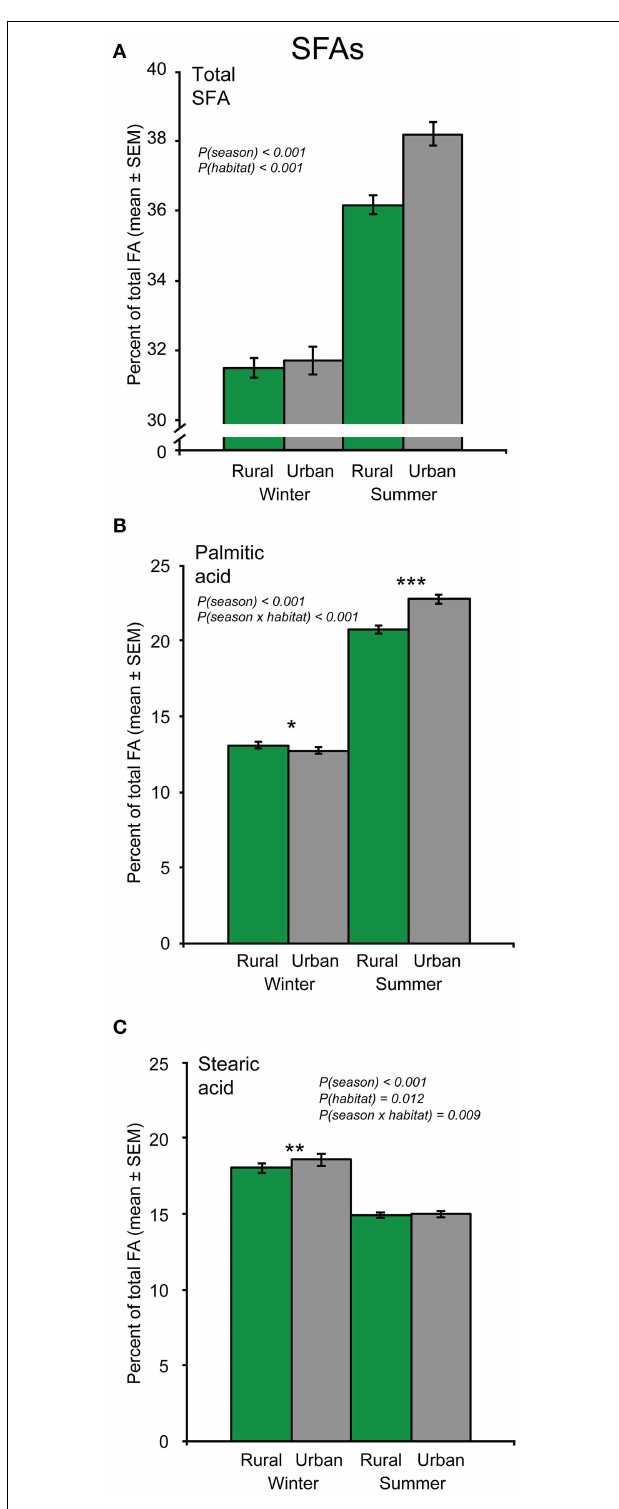
FIGURE 6 | The proportion of saturated fatty acids (SFA) in great tit blood plasma sampled during winter and summer in the urban and rural habitats ( N total = 126 ). (A) Total SFA (i.e., the sum of myristic-, palmitic-, stearic-, and arachidic acid), (B) palmitic acid, and (C) stearic